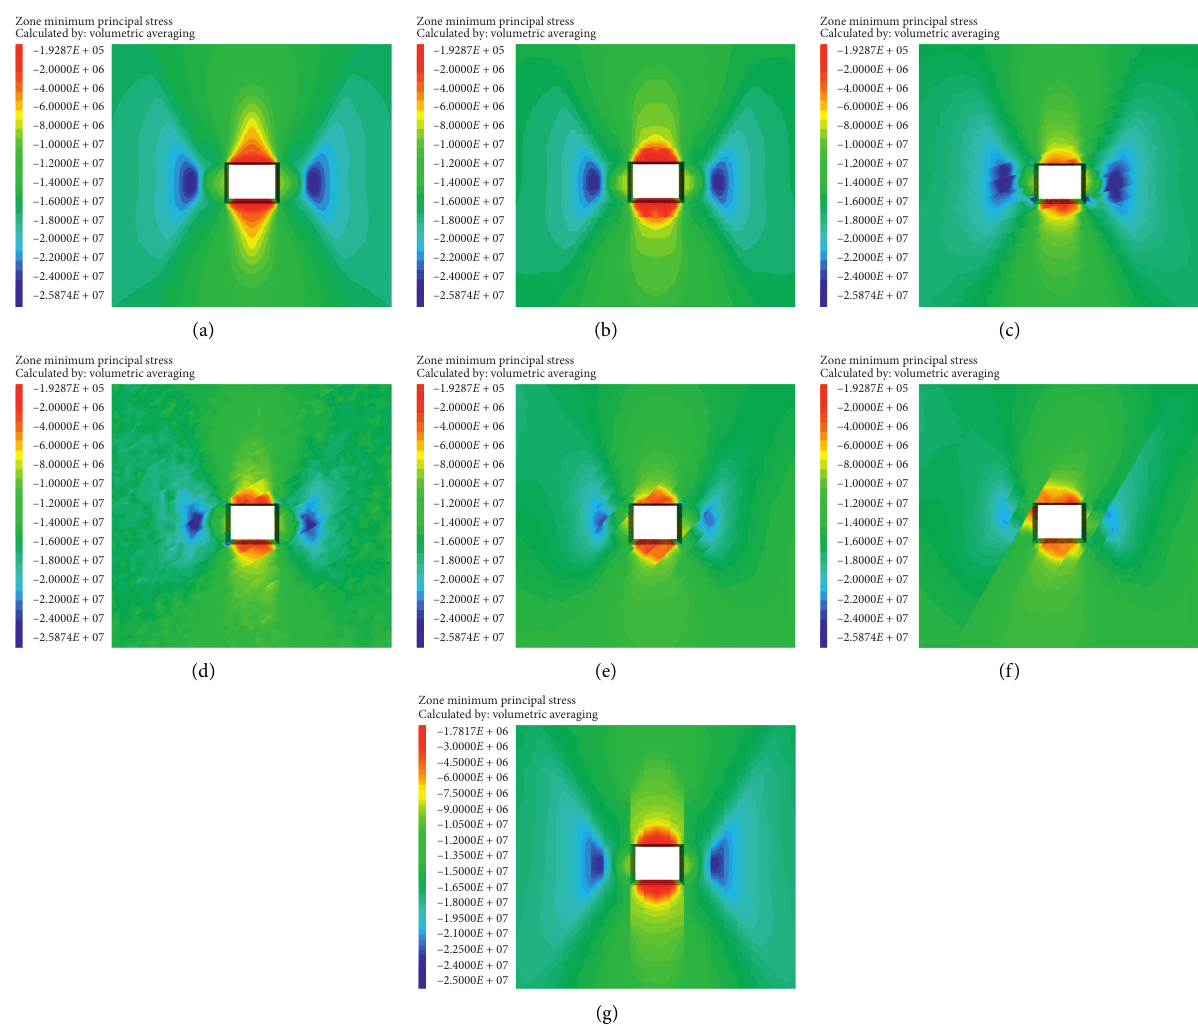
Figure 5: Distribution cloud diagram of minimum principal stress. (a) No structural plane. (b) 0 ° . (c) 15 ° . (d) 30 ° . (e) 45 ° . (f) 60 ° . (g) 90 °